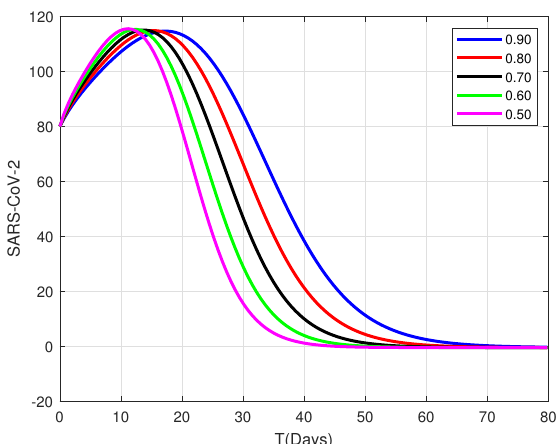
Figure 4. Graphical representation of the approximate solutions of the SARS-CoV-2 model for order α = 0.9, 0.8, 0.7, 0.6,